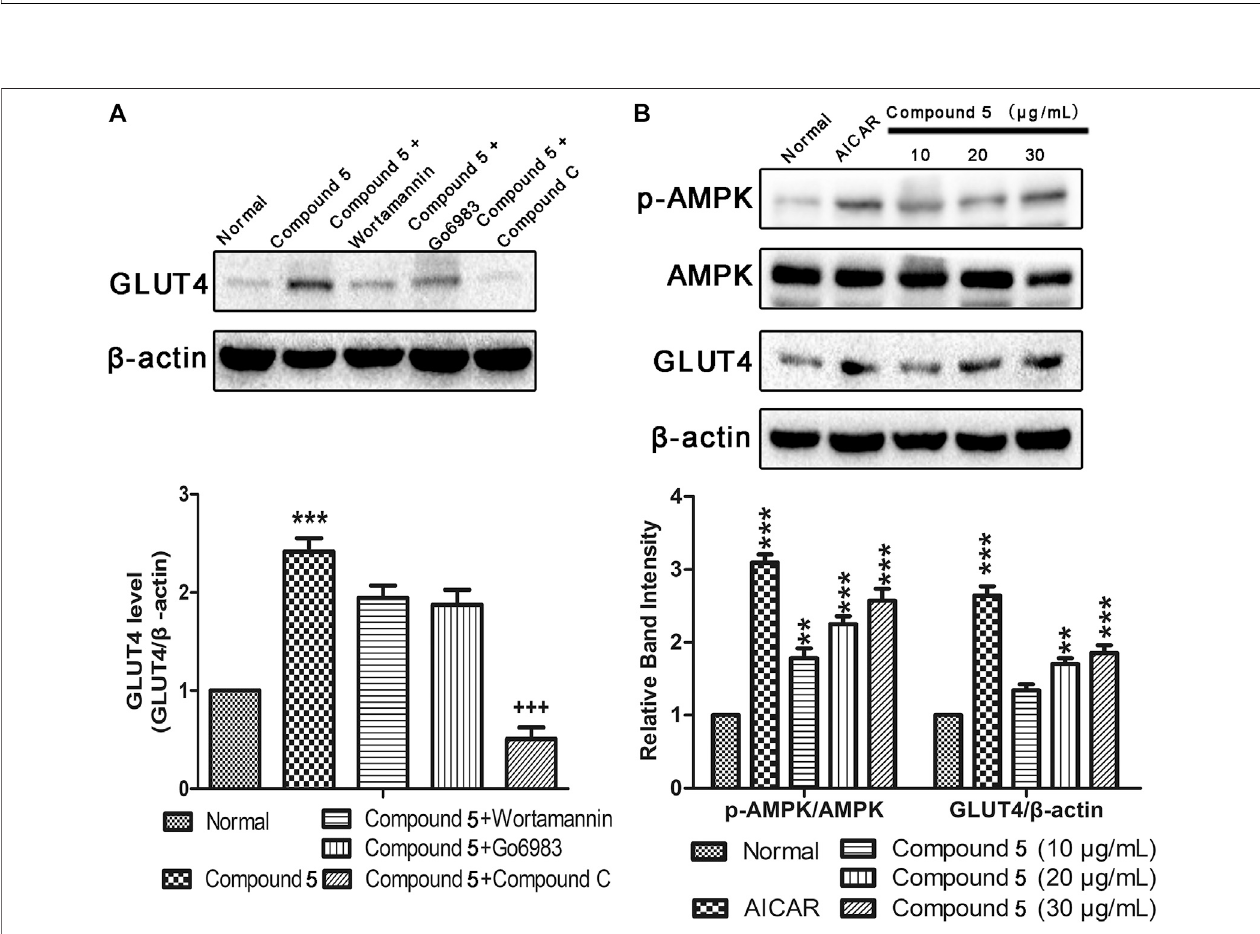
FIGURE 8 | Effects of compound 5 in vitro . (A) Compound C completely inhibited the GLUT4 expression induced by compound 5 (30 μ g/ml), while Wortmannin and Go6983 showed no obvious effects. *** p < 0.001, compared with normal, +++ p < 0.001 compared with compound 5. (B) Compound 5 at 30 μ g/ml notably enhancedAMPK phosphorylationand GLUT4 expressions, respectively. Data areshown asmean ± SEM. * p < 0.05, ** p < 0.01, *** p < 0.001 compared with NC group.